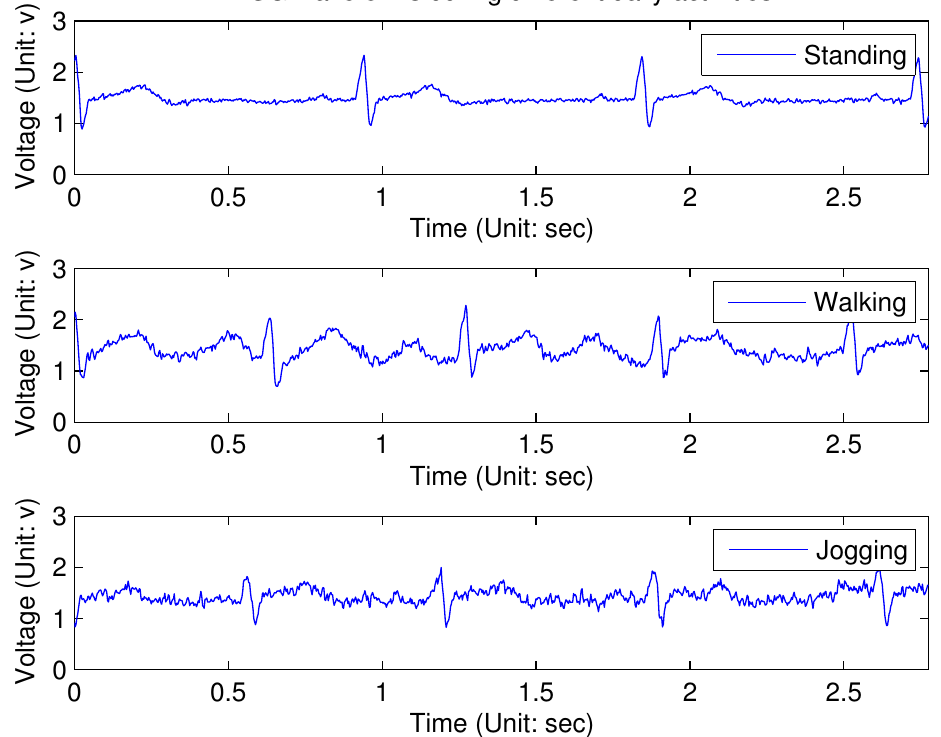
Figure 6. ECG waveforms captured during different daily activities. The charts show a three-second